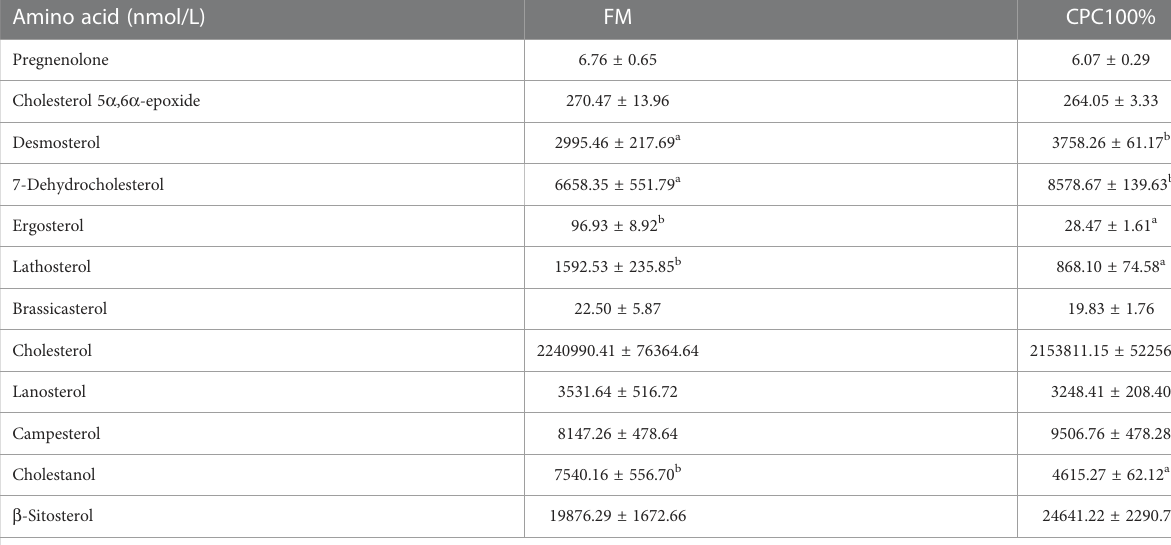
TABLE 8 Free sterols in serum of rainbow trout fed different diets (Mean ± S.E., n =6). Amino acid